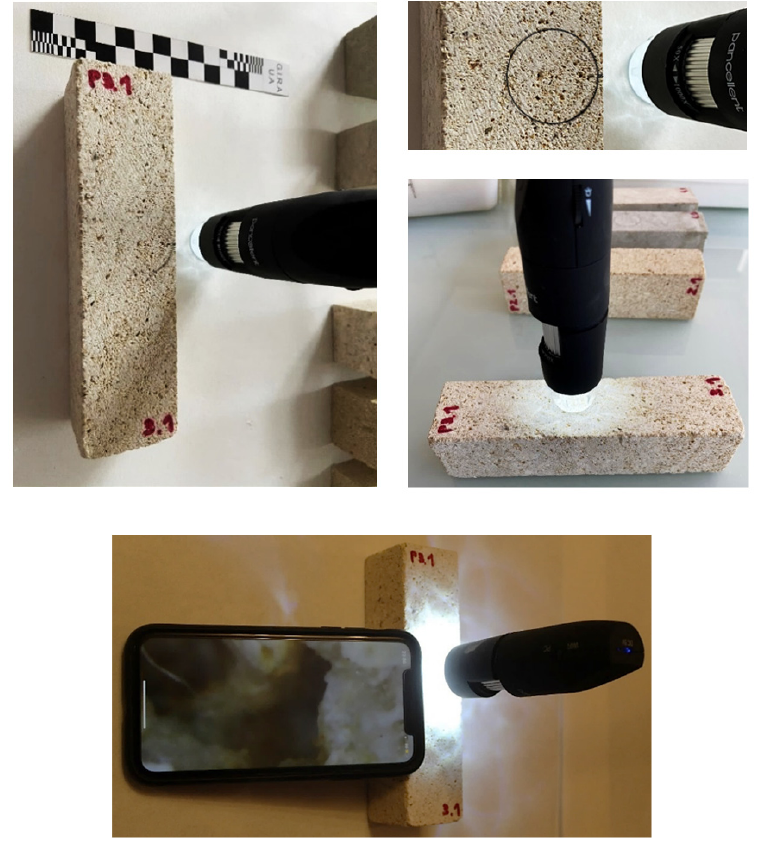
Figure 8. Specimen P3.1 (Bateig Crema Maroc) subjected to microscopic analysis using the Pancel ‐ lent wireless digital optical microscope.